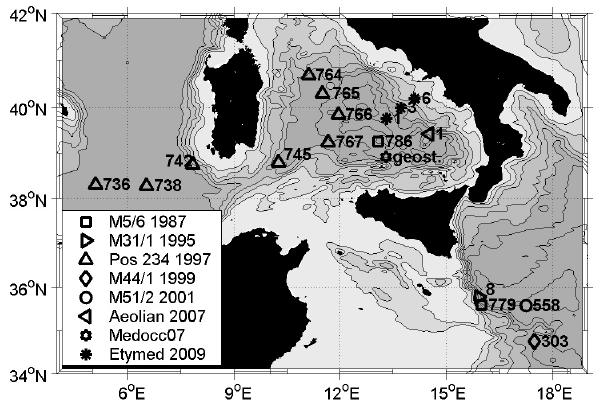
Fig. 1. Map of stations used in the present work. Station numbers are given next to the markings. For cruises see Table 1. Depth isolines are 500m apart. Malta Escarpment = steep slope near 1995 Sta. 8; Sardinian Channel = deep connection between Tyrrhenian and WMed south of